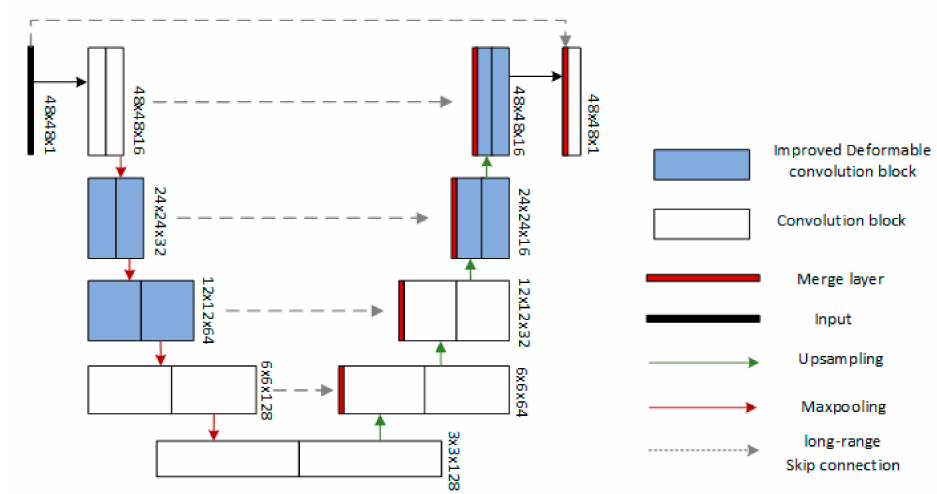
Figure 5. Overall structure of RDU-Net, Output size of feature map is listed beside each two layers.